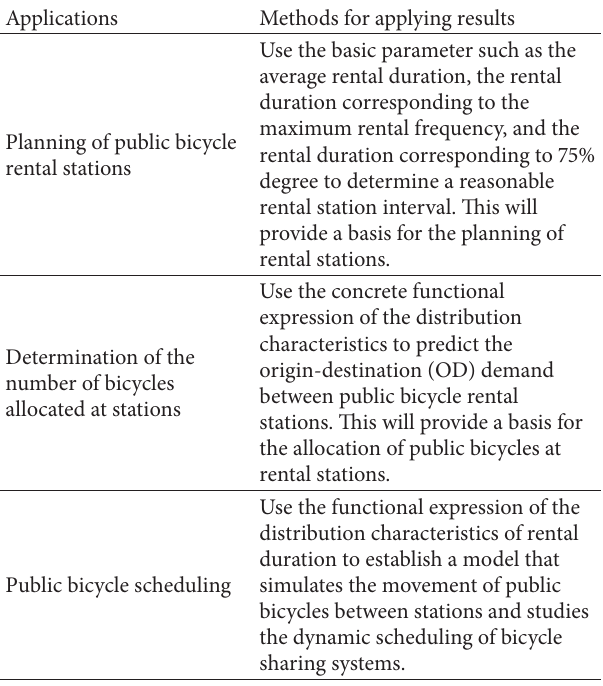
Table 6: Applications of the study